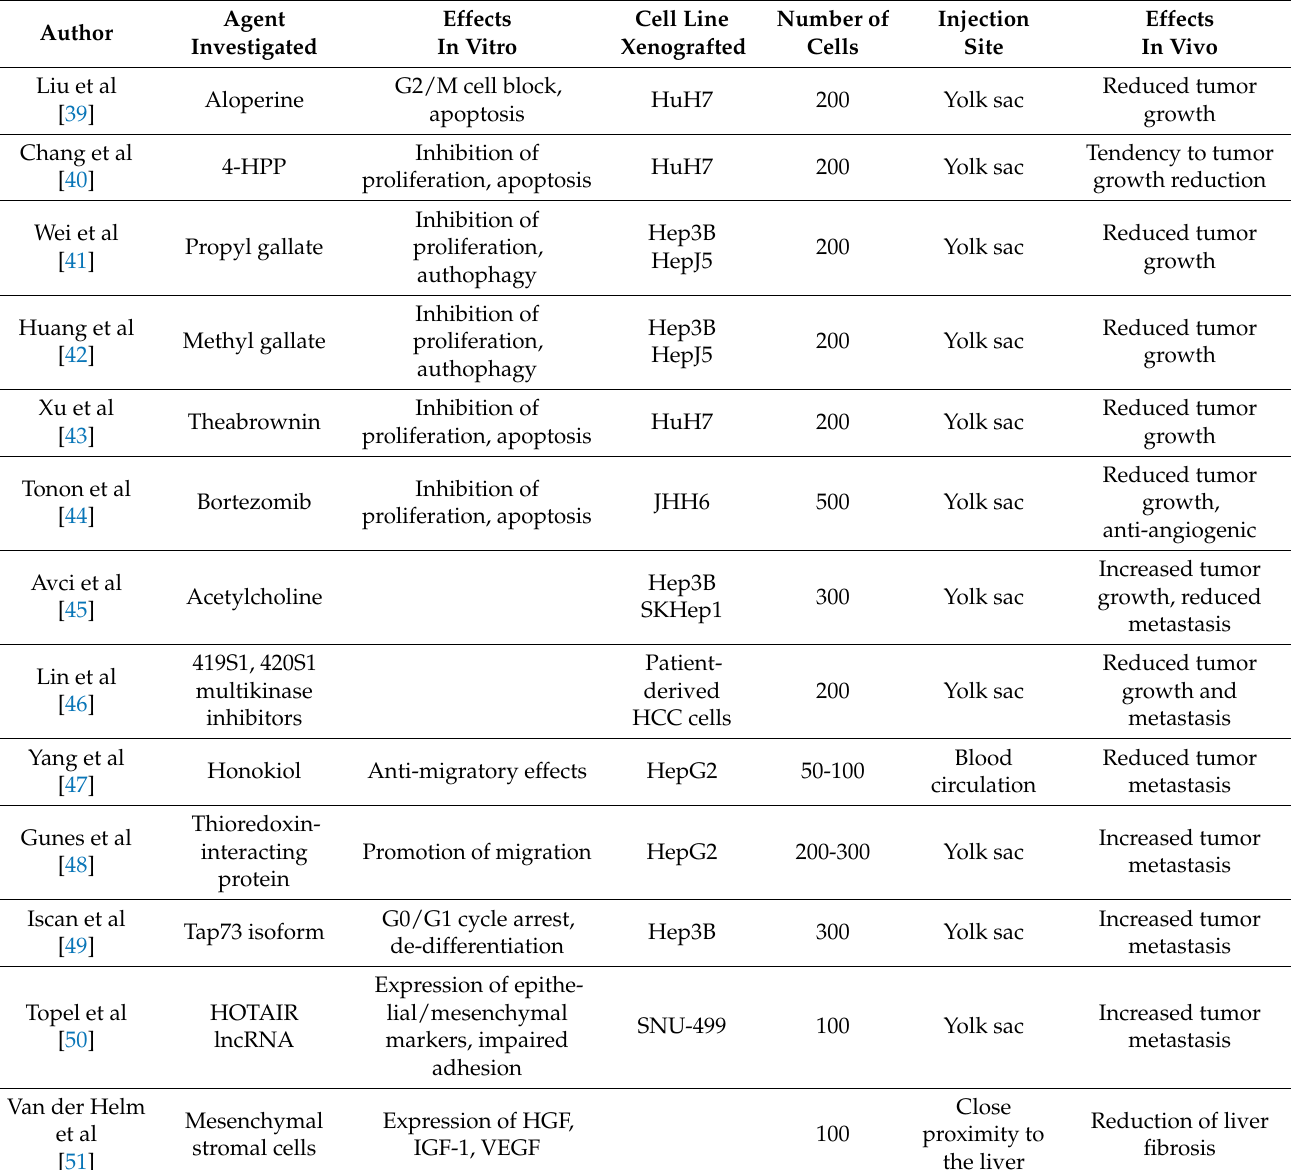
Table 1. HCC Xenograf zebrafish models.